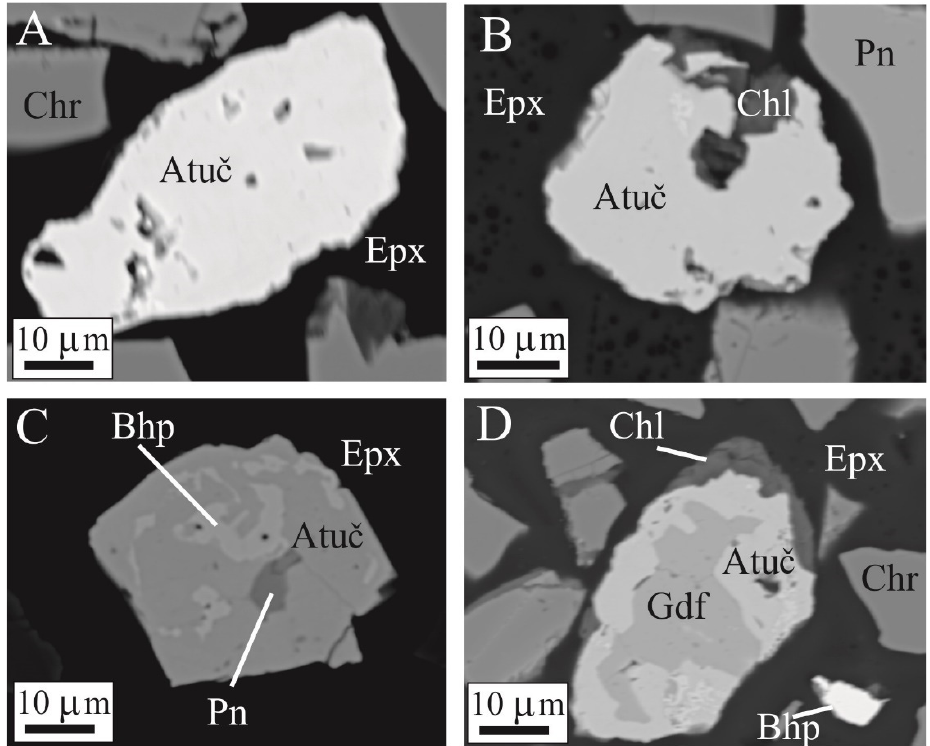
Figure 3. BSE images showing arsenotu č ekite discovered in the Eretria (Tsangli) chromium mine. Single ‐ phase grains ( A,B ), and composite grains consist of arsenotu č ekite, breithauptite, pentlandite and gersdorffite ( C,D ). Arsenotu č ekite in contact with chlorite is shown in ( B ) and ( D ). Symbols: Atu č = arsenotu č ekite, Pn = pentlandite, Bhp = breithauptite, Gdf = gersdorffite, Chr = chromite, Epx = epoxy. The photos A ‐ C are taken by Zaccarini et al. [10].